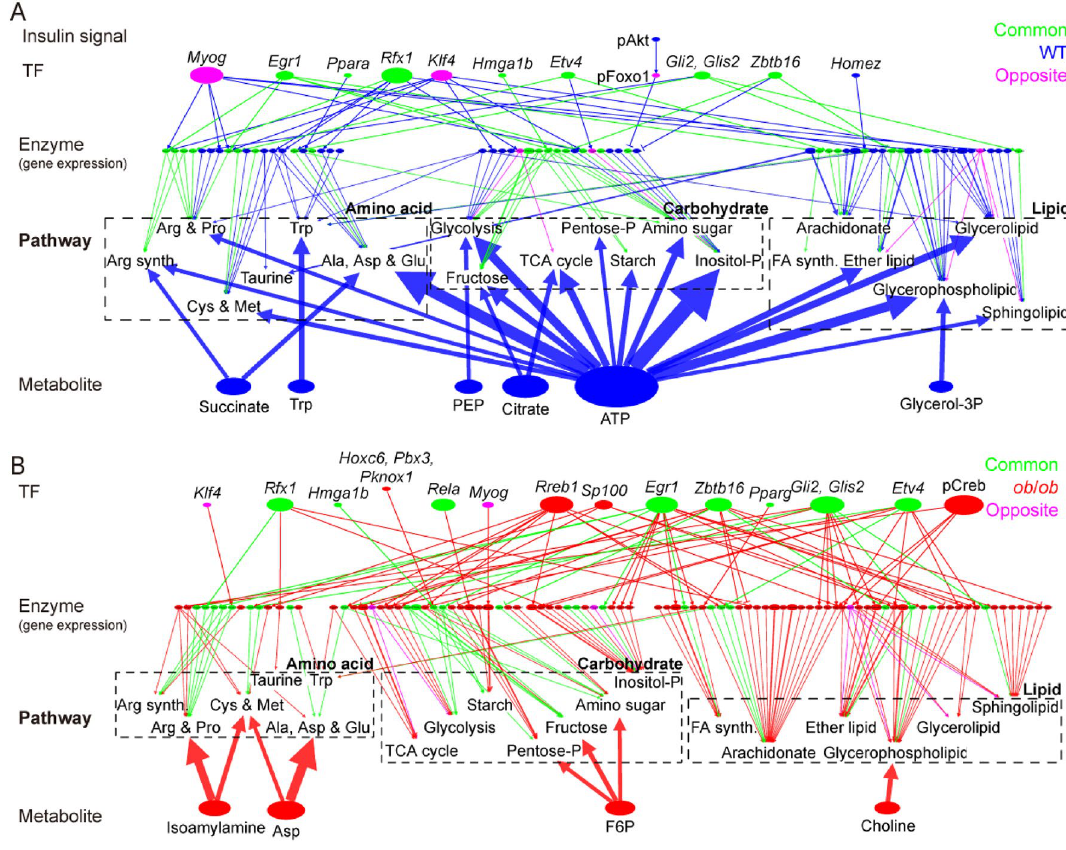
Figure 6. Condensed regulatory transomic networks for glucose-responsive metabolic reactions. ( A,B ) The condensed regulatory transomic network of the response to glucose in WT and ob / ob mice. The color of nodes (glucose-responsive molecules) and edges (interlayer regulatory connections) indicate the type of molecules and regulation as described in Fig. 5B. In the TF layer, the transcription factors encoded by glucose-responsive genes are italicized, and those showing glucose-responsive phosphorylation have the prefix “p.” The Enzyme layer contained only the metabolic enzymes that were regulated by glucose-responsive changes in gene expression, and not those regulated only by phosphorylation. Two types of metabolic pathway nodes were included: the pathway that exhibited significant associations with any glucose-responsive molecule (Fig. S7B); and the pathway whose percentage of regulated reactions was in the top 10% by either glucose-responsive metabolites or by glucose-responsive genes encoding metabolic enzymes. Dashed boxes enclose the nodes for the lipid, carbohydrate, and amino acid classes. Glucose-responsive metabolites that exhibited significant associations with any metabolic pathway were included. Glucose-responsive transcription factors that regulated five or more metabolic reactions were included. The interlayer regulatory connections from the Metabolite to the Pathway layer included only those that regulate five or more metabolic reactions. The size of the nodes and width of the edges indicate the relative number of the regulated metabolic reactions. See Data File S10 for the unabbreviated names of the metabolic pathway